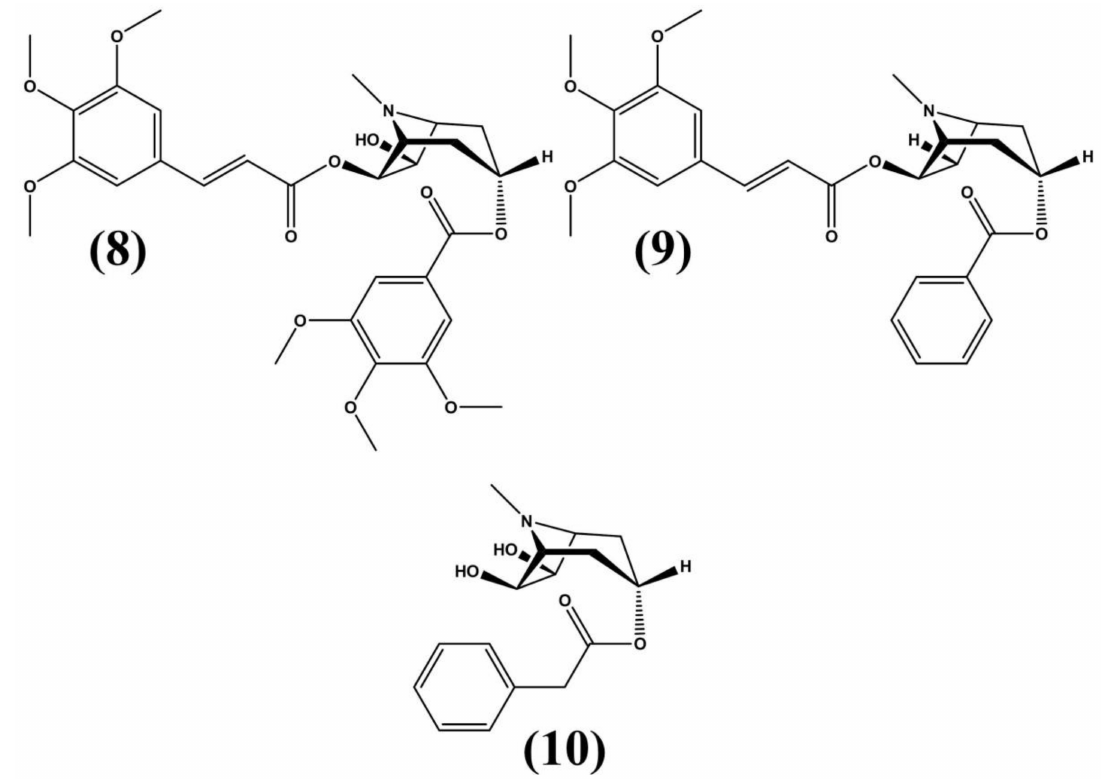
Figure 5. Pervilleine A ( 8 ) and other aromatic esters isolated from extracts of E. pervillei